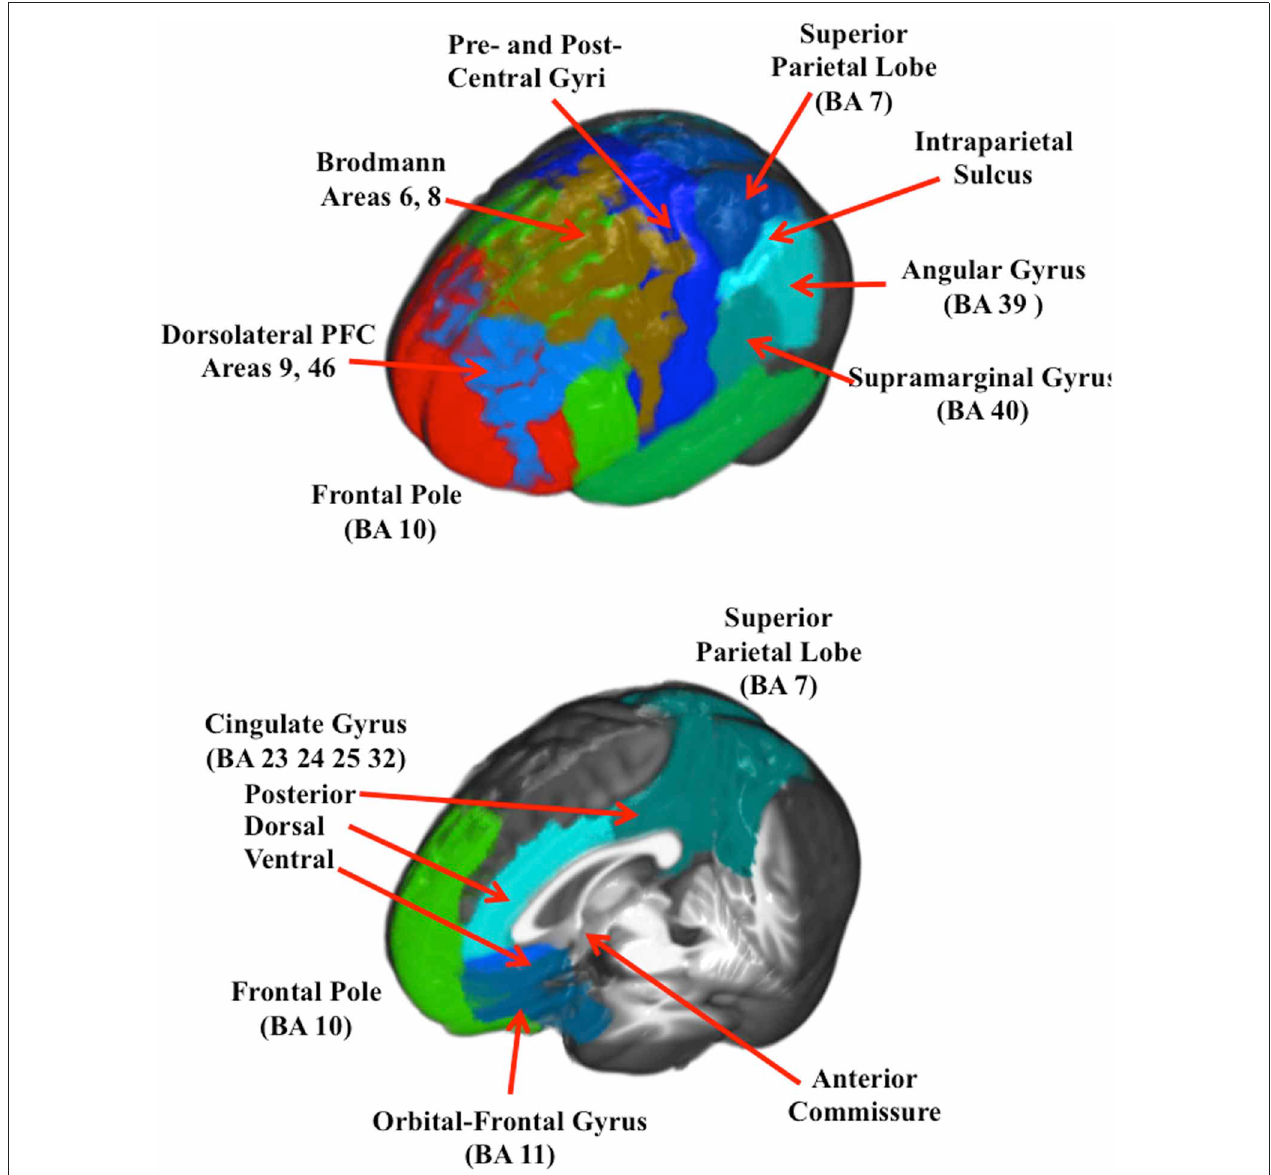
FIGURE 3 | A 3-D rendered brain showing the ROIs for the lateral regions (top figure) and the ROIs with only central regios (bottom figure).